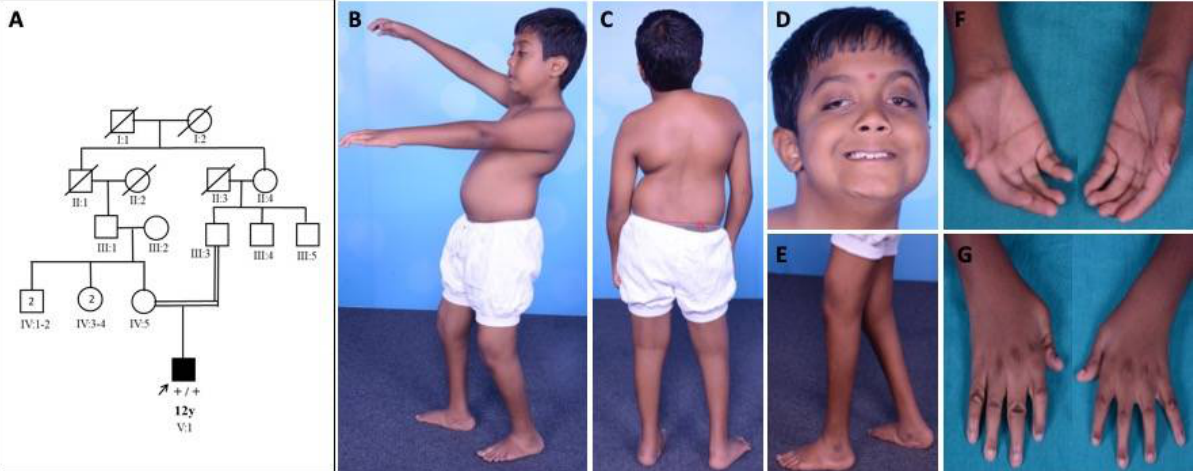
Figure 1. Pedigree and clinical images of patient 1 with DA5D: ( A ) pedigree of family 1; ( B , C ) kyphoscoliosis with bilateral hip and knee contracture; ( D ) asymmetric ptosis; ( E ) calf atrophy, contracture at the knee, pes planus, prominent calcaneum; ( F , G ) contractures of fingers with absent abductor pollicis brevis.